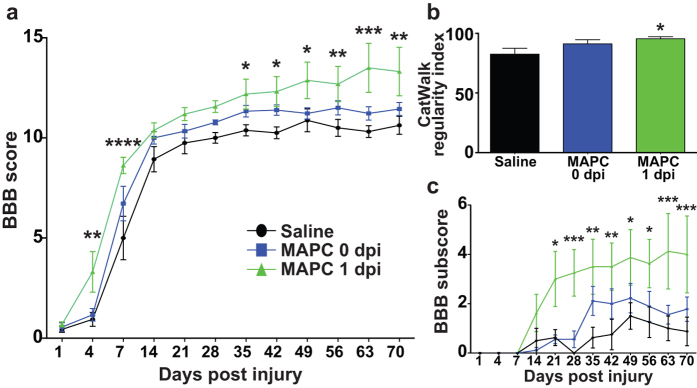
MAPC treatment one day post injury improves locomotor recovery.The (a) BBB scale and (c) BBB subscale of rats treated with Saline, MAPC 0 dpi or MAPC 1 dpi over a 10 weeks postoperative period. n = 8 Saline, 9 MAPC 0 dpi, 8 MAPC 1 dpi. *p < 0.05, **p < 0.01, ***p < 0.001, ****p < 0.0001 when compared to Saline treated. Two-way repeated measures ANOVA Fisher’s Least Significant Difference post-hoc test. (b) Interlimb coordination at 10 weeks post injury as measured by CatWalk regularity index. n = 7 Saline, 8 0 dpi , 8 1 dpi. *p < 0.05 when compared to Saline treated. Kruskal-Wallis ANOVA with Dunn’s post-hoc test. Data represent mean and s.e.m.